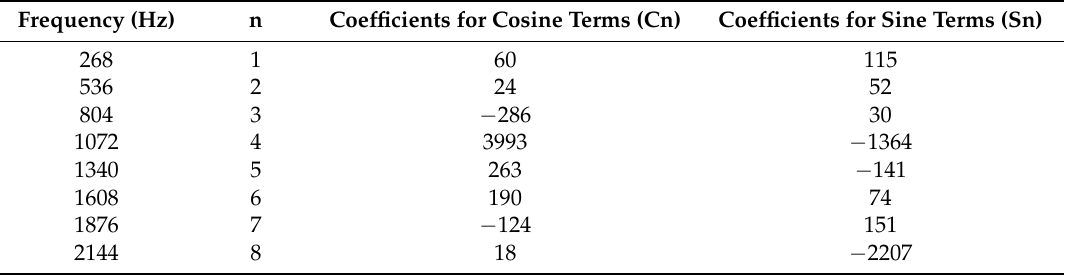
Table 6. The coefficients at dominant frequencies